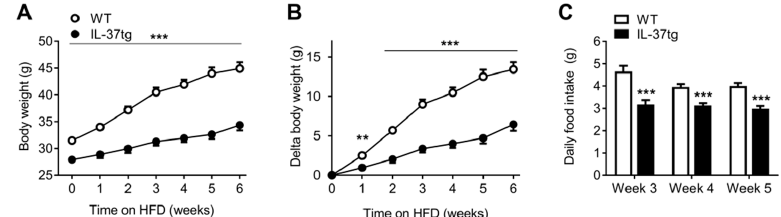
Figure 1. IL-37 expression alleviates diet-induced weight gain and reduces food intake. 10-week old male C57Bl/6J mice and homozygous IL-37tg mice on a C57Bl/6J background were fed a high-fat diet (HFD) for 6 weeks. Body weight ( A , B ) and food intake ( C ) were measured at indicated time points. Values represent means ± SEM ( n = 10 animals per group). ** p < 0.01, *** p < 0.001 vs. wild-type (WT).